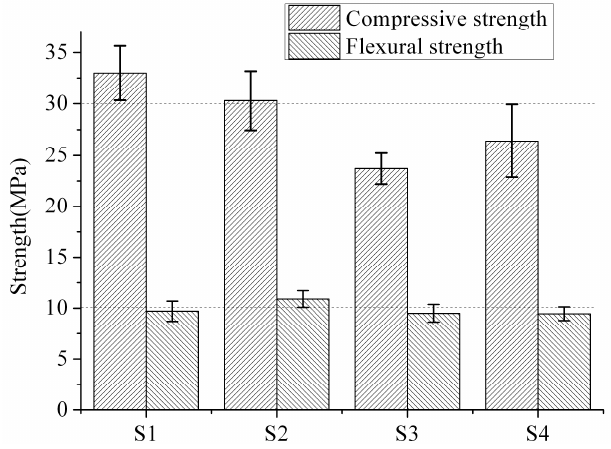
Figure 5. Compressive and flexural strength of 7d ECC.